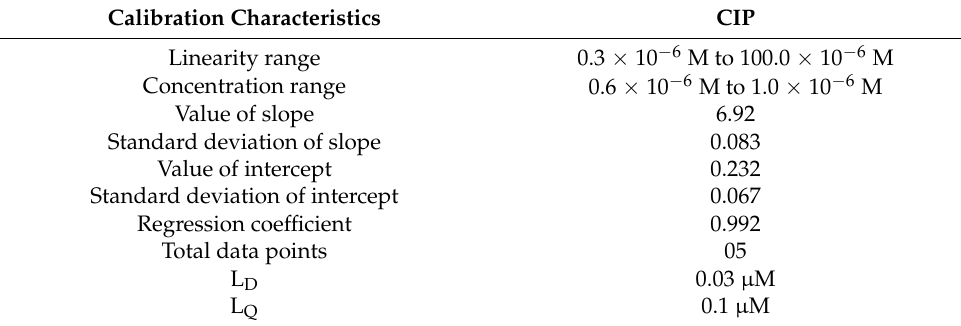
Table 1. Calibration features of CIP.